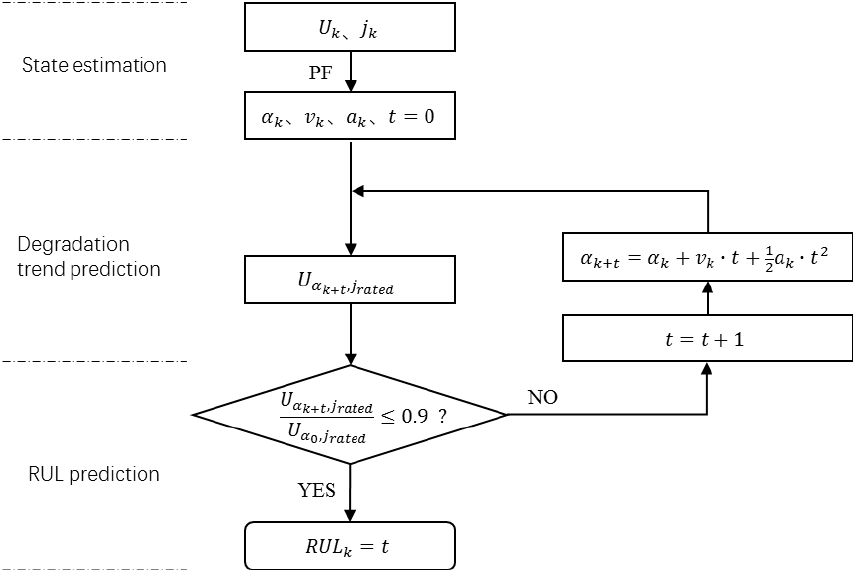
Figure 8. The degradation trend and remaining useful life (RUL) prediction algorithm.